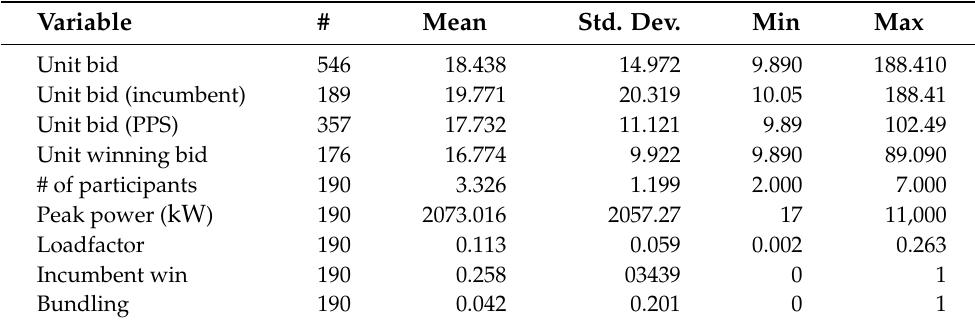
Table 1. Summary